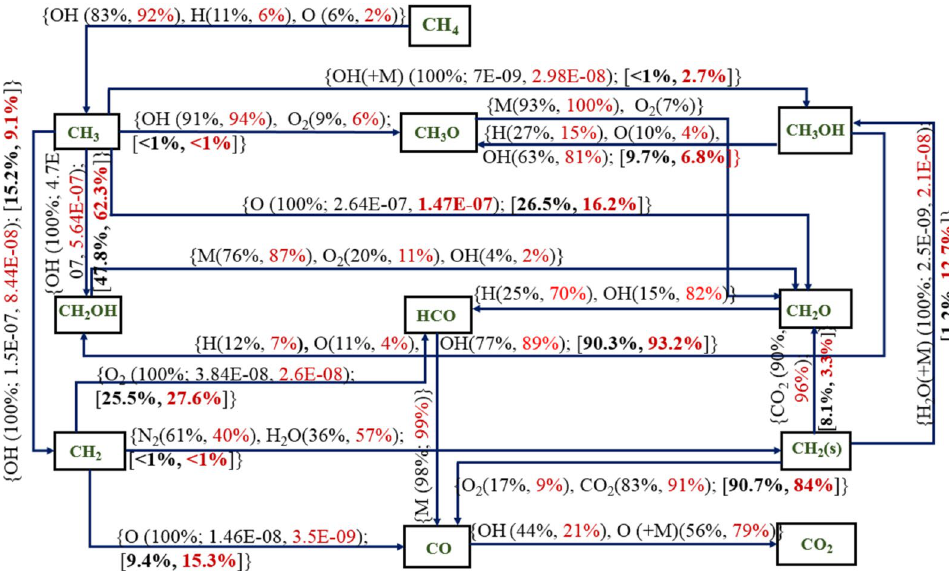
Figure 16. Methane–air combustion with no dilution (values in black color) and 20% dilution (values in red color) at 393 K and P = 1 atm for Aramco 3.0 mechanism with a residence time of 0.5 s, and the values within the square bracket represents the branching percentage of the particular reaction from the precursor intermediate